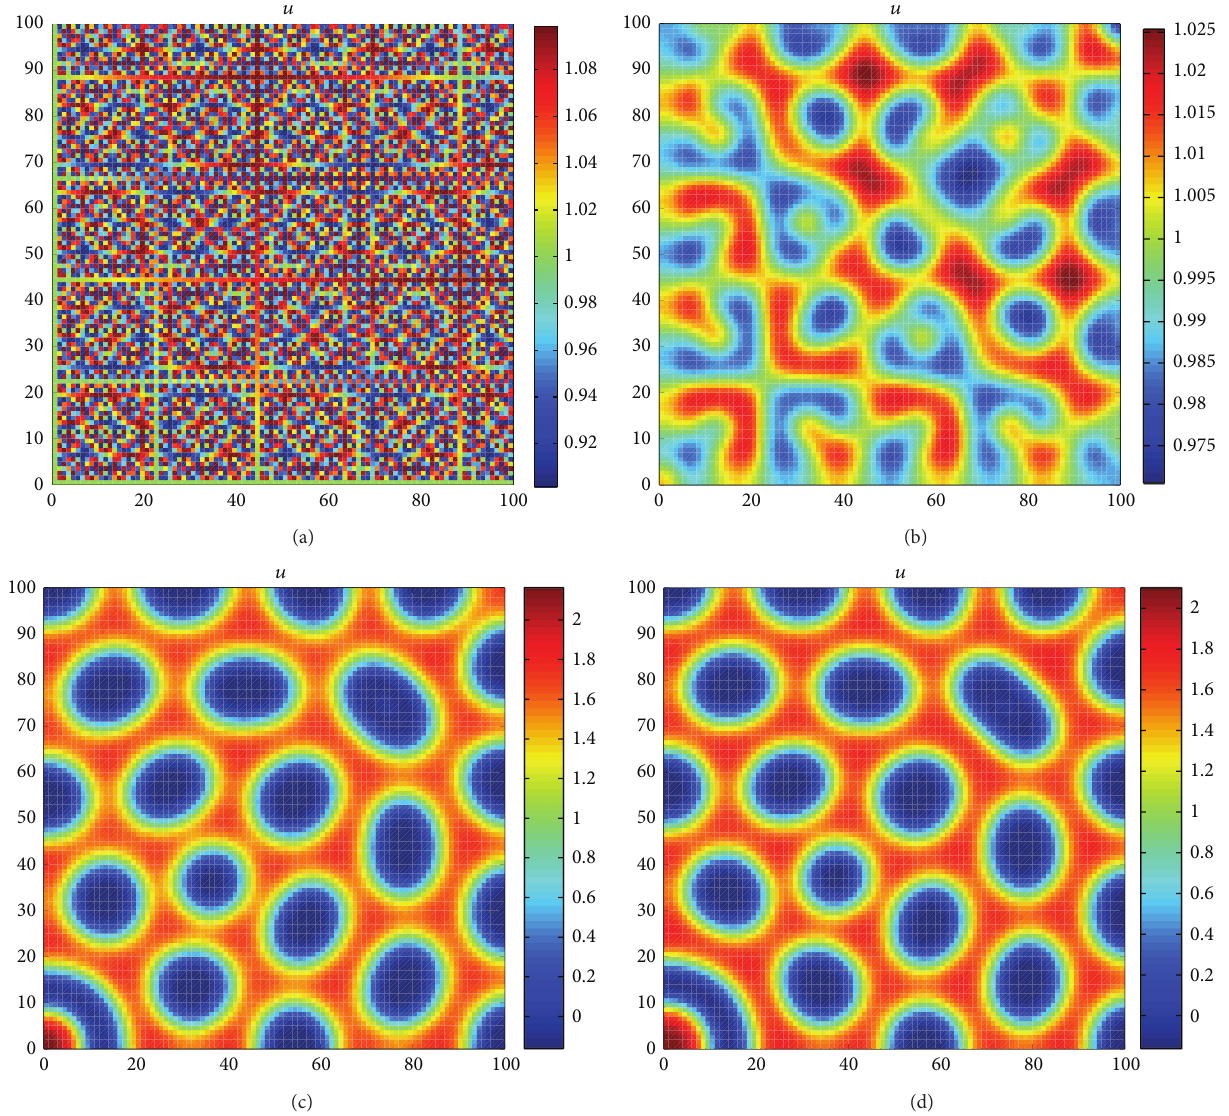
Figure 1: The spotted patterns prevail over the two-dimensional space. And [(a)–(d)] are, respectively, at time 0, 10, 500, 1000. Parameter values and initial perturbation, respectively, are 𝛿 = 0.3 , 𝛾 = 0.2 , 0.1 sin (𝑥𝑦) , 0.1 cos (𝑥𝑦) .